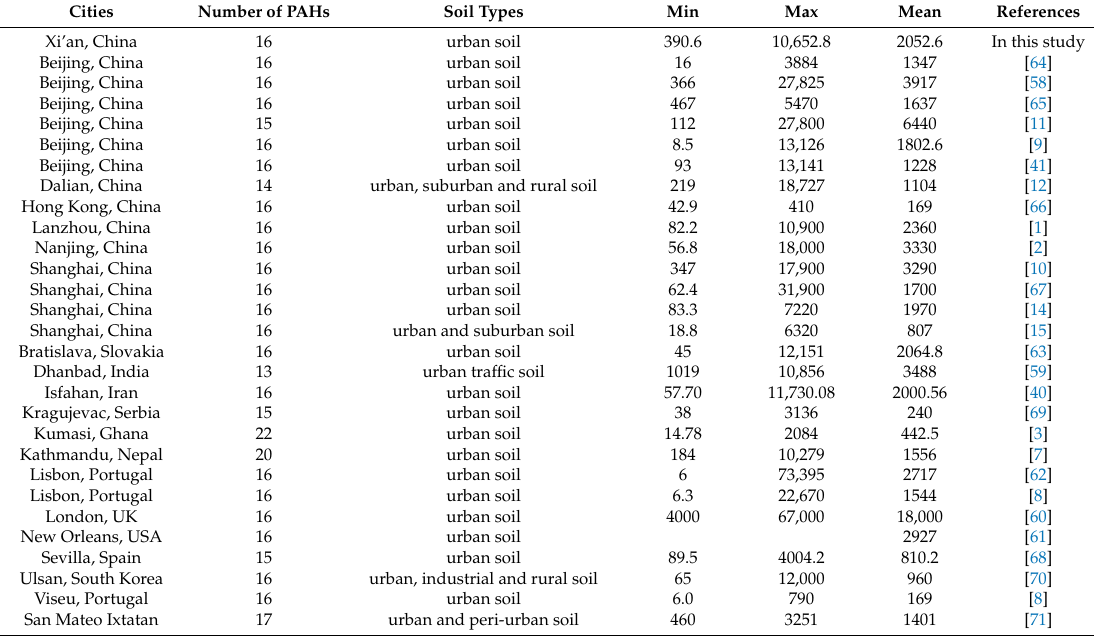
Table 4. Concentration comparison of Σ PAHs in soil from worldwide different cities ( µ g/kg).